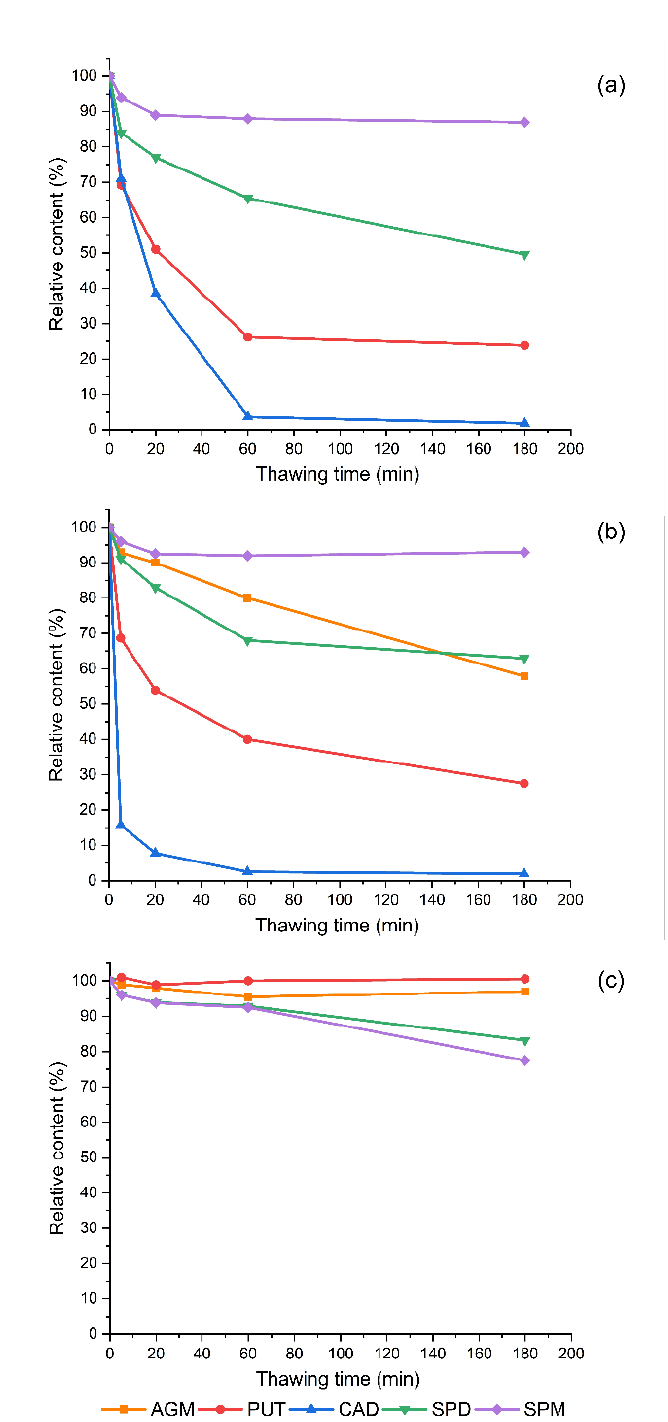
Figure A1. Time-dependent change in the content of polyamines (agmatine (AGM), putrescine (PUT), cadaverine (CAD), spermidine (SPD), and spermine (SPM)) during thawing of the frozen sprouts of ( a ) lentil, ( b ) alfalfa, and ( c ) daikon radish.